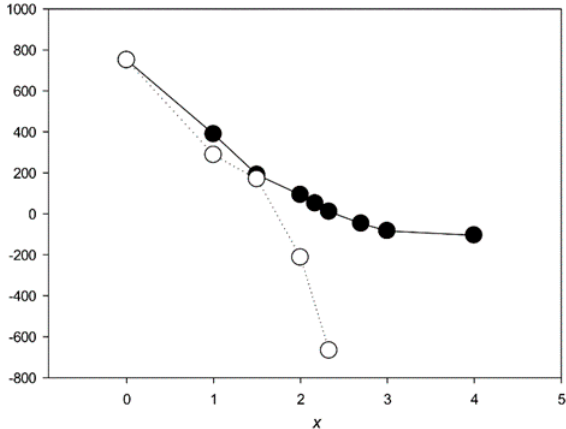
Figure 4. Z ( x ) for MSAs produced by ClustalW [27] (black circles) and Clustal Omega [28] (white circles).